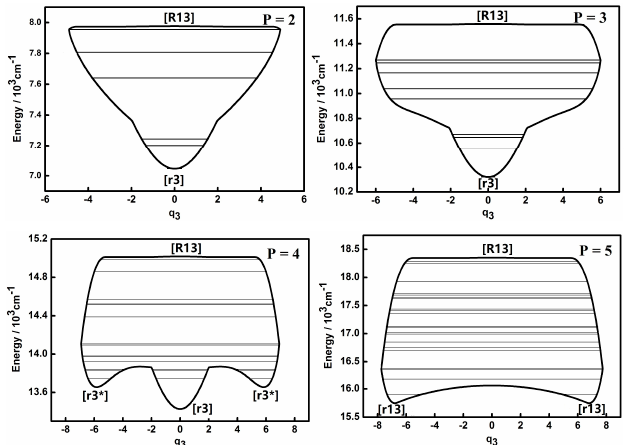
Figure 2. Dynamic potentials of the non-integrable HOCl system (obtained with H ( q 1 ,p 1 ,q 3 ,p 3 ,P ), q 3 , coordinate) with P = 2, 3, 4, 5, and the energy levels included in the dynamic potential are shown by the lines.